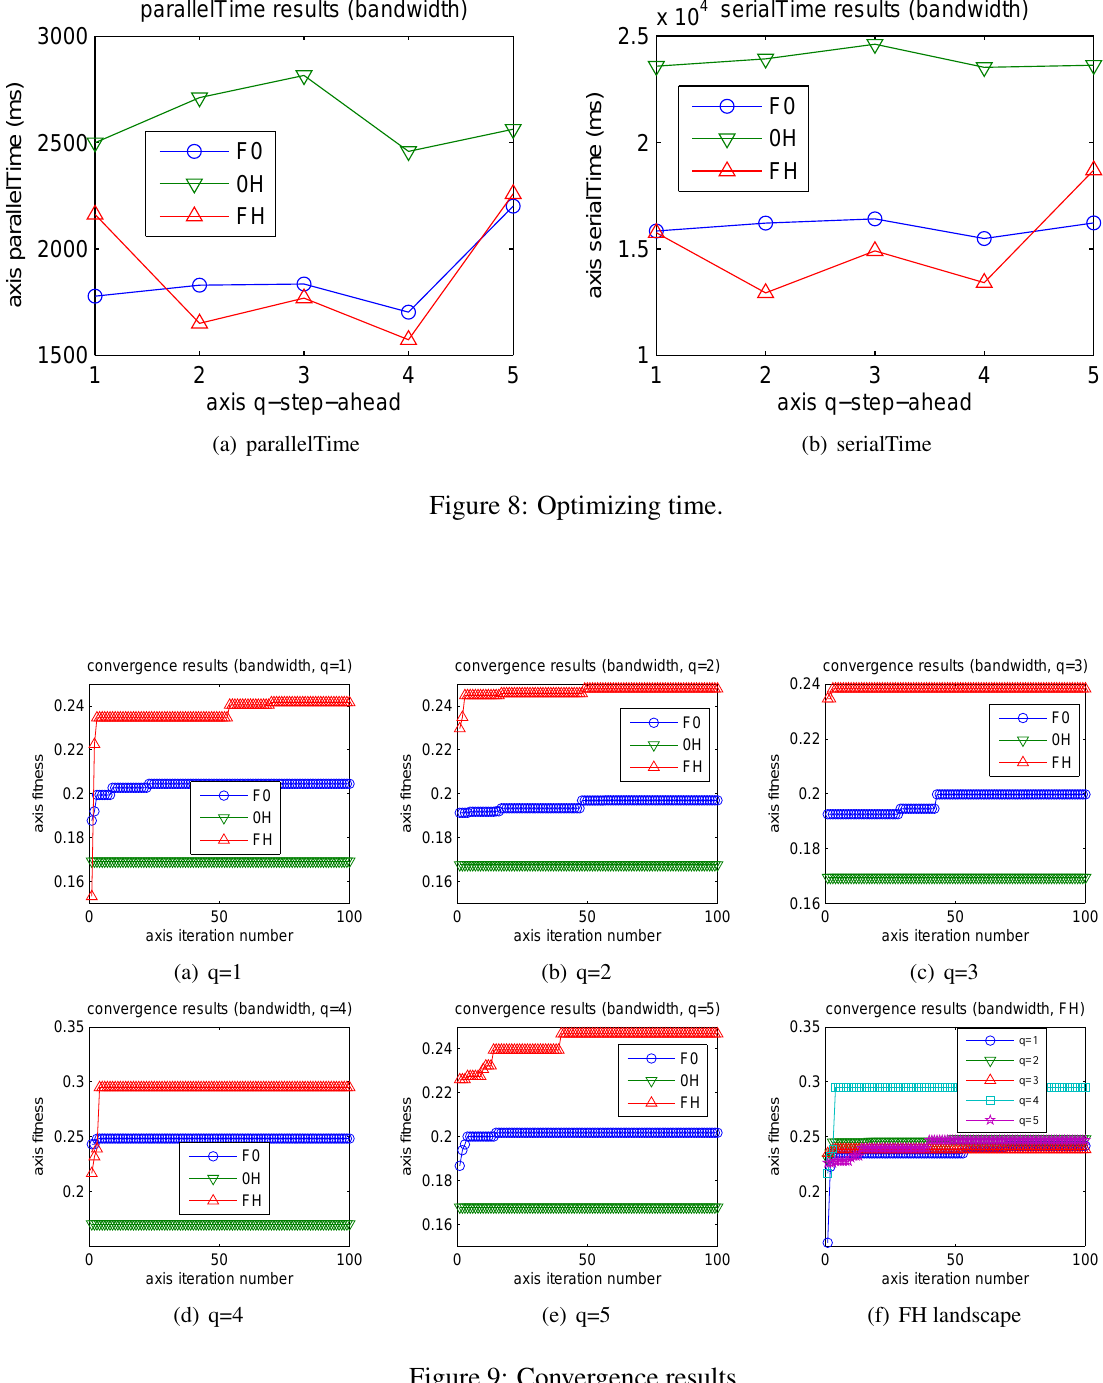
Figure 9: Convergence